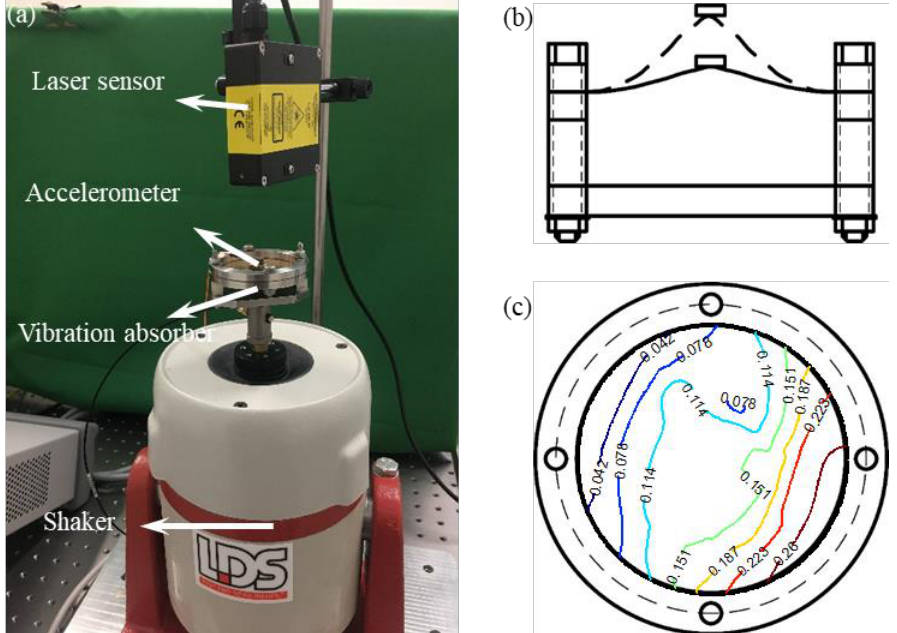
Figure 6. Test rig and schematic model of the vibration absorber. ( a ) Photo of the test rig, ( b ) elevation view, ( c ) Plan view and contour plot for the measured geometric imperfections. Relative deviations are in millimeters.